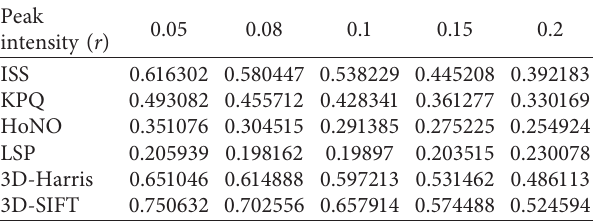
Table 3: Gaussian noise repetition rate r detection algorithm on the Random View data set.